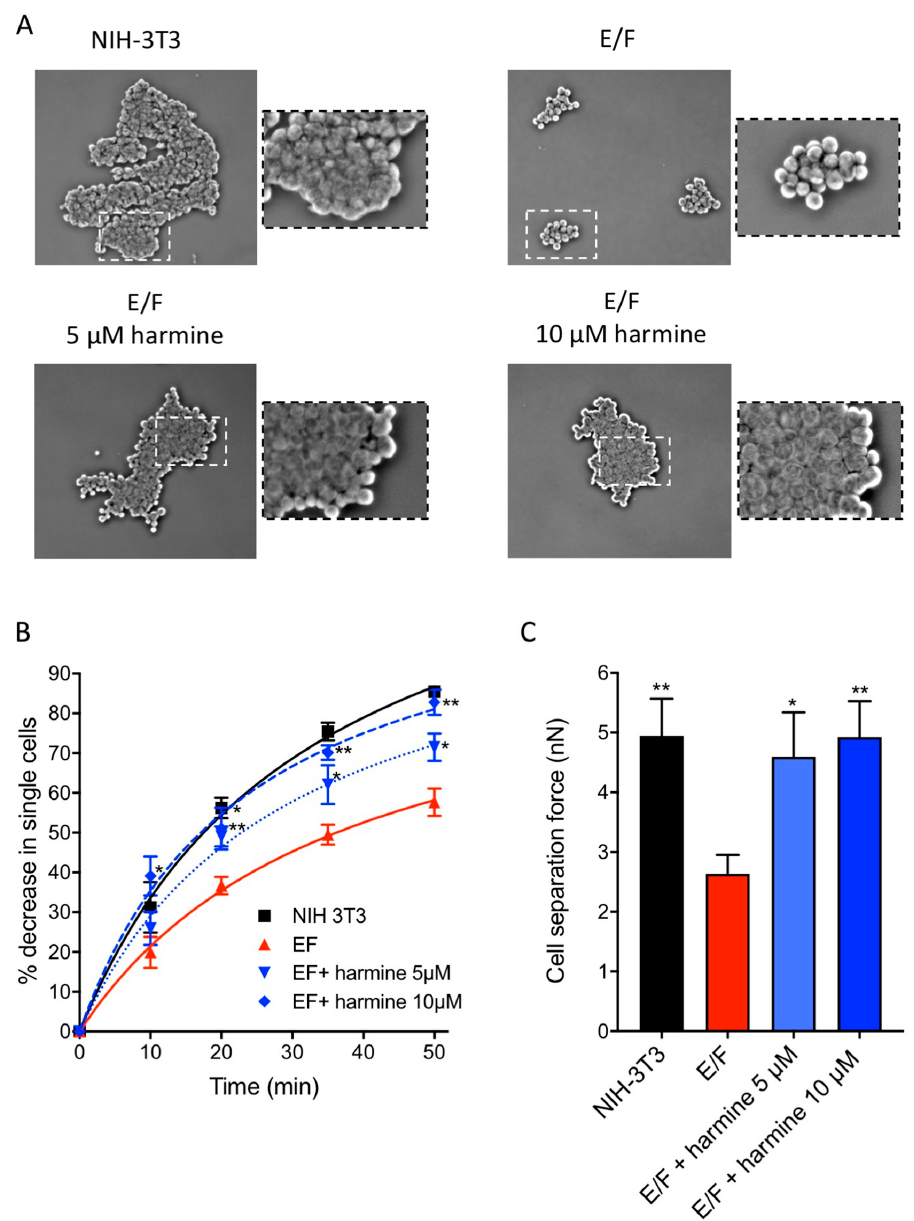
Figure 4. Effect of harmine on the E/F cell aggregation potency and cell separation force. NIH-3T3 and E/F cells were cultured for 48 h in the presence or not of harmine as indicated, then they were gently dissociated. ( A , B ) To test the cell aggregation potency, suspensions of isolated cells were shaken during 50 min and cell aggregation was assessed by determining the disappearance of isolated cells over time using a phase-contrast microscopic observation. ( A ) Representative images of cell aggregates after 50 min of shaking from at least three independent experiments (10× objective). ( B ) Graphic representation of the disappearance in isolated cells as a function of time. The results presented are means ± SEM for three independent experiments. * p < 0.05; ** p < 0.01 versus control untreated E/F cells. ( C ) To test the strength of the intercellular adhesion, two isolated cells are brought into contact for 30 s then the cell doublet separation force is measured using a dual pipette assay. Forces are expressed in nanonewtons. Results are means ± SEM of at least 20 doublet measurements in three independent experiments. * p < 0.05; ** p < 0.01 versus control untreated E/F cells.